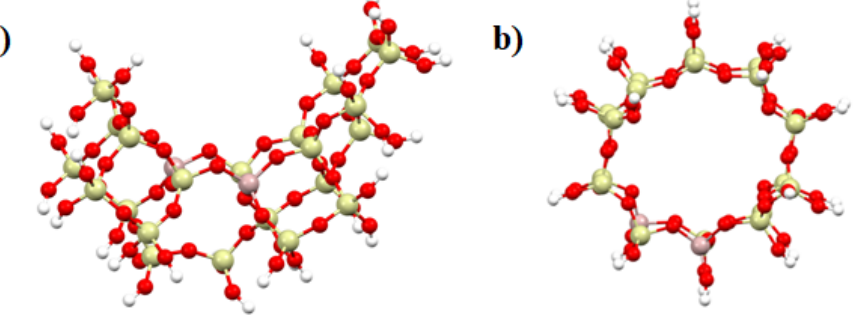
Figure 1. Cluster model of zeolite structures ( a ) FAU (Al 2 Si 22 O 66 H 6 ) and ( b ) MFI (Al 2 Si 18 O 53 H 26 ), where Si (yellow), Al (pink), O (red) and H (white).